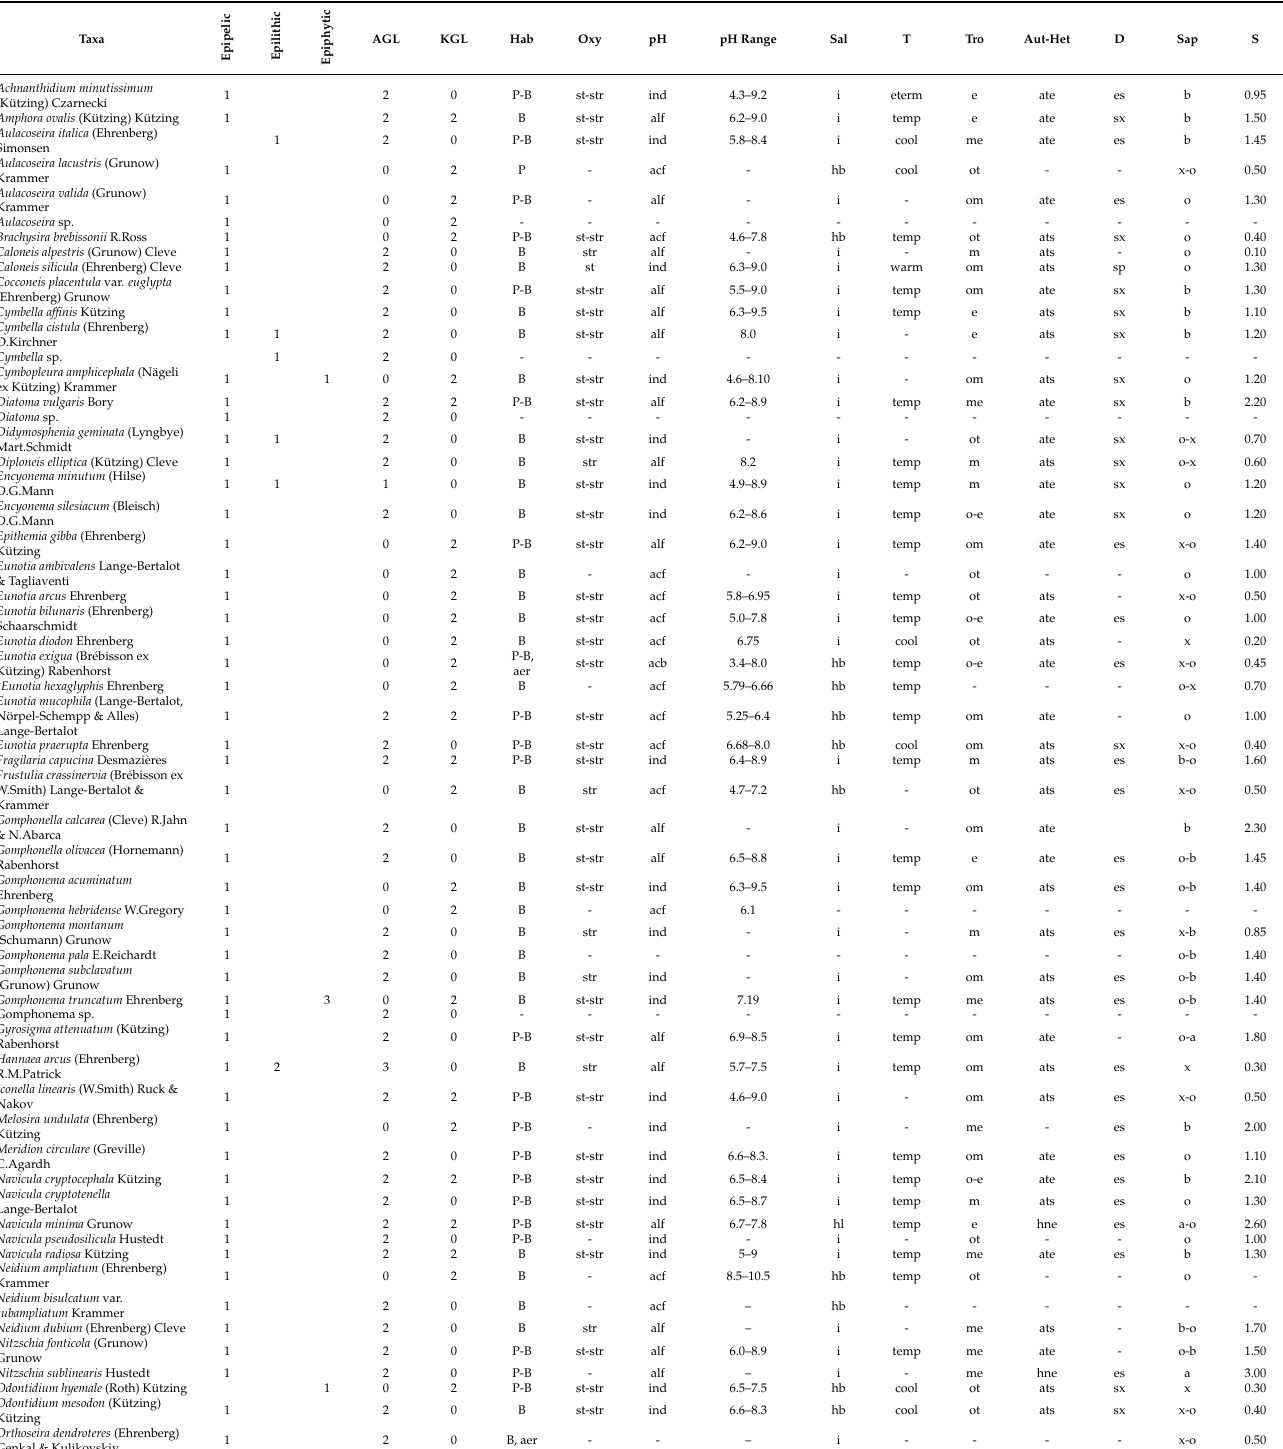
Table 2. List of identified diatoms in the Avusor Great Lake (AGL) and Koçdüzü Great Lake (KGL) with abundance scores and ecological